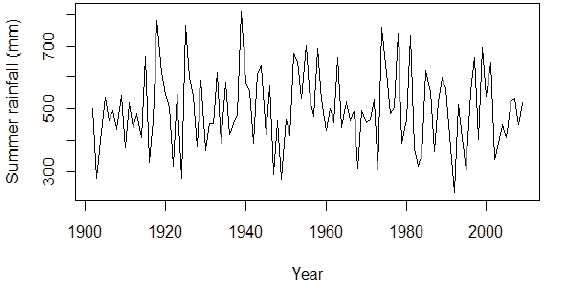
Fig. 1. Time series plot of summer rainfall for the period 1901 to 2009 (in-sample)